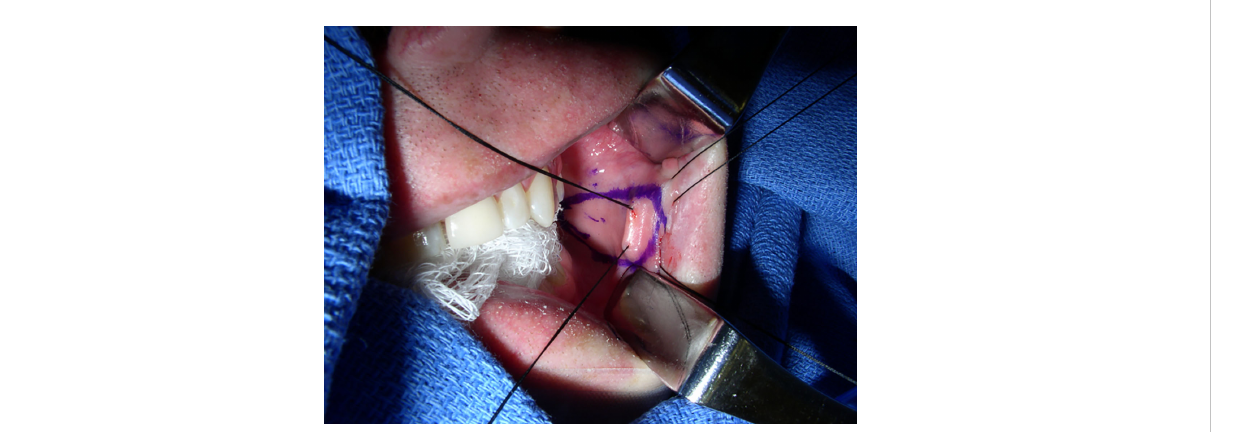
FIGURE 1 Typical setup for BMG harvest. The dry X-ray-detectable gauze sponge is packed to the contralateral oral space, and three retraction sutures are used with the middle incorporated into the distal apex of the graft. The Army – Navy retractors were used only for photographic exposure of the